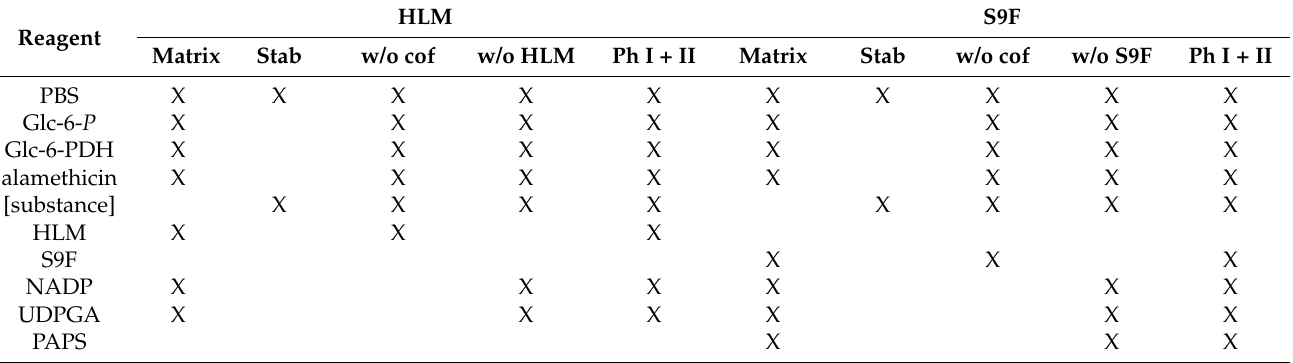
Table 3. Pipetting scheme of the human liver microsome and the human liver S9 fraction metabolism assay. HLM: human liver microsomes, S9F: human liver S9 fraction; matrix: matrix control, stab: stability control, w/o cof: control without cofactors, w/o HLM: control without HLM, w/o S9F: control without S9F, Ph I + II: phase I and II metabolism; PBS: phosphate-buffered saline; Glc-6- P : glucose-6-phosphate; Glc-6-PDH: glucose-6-phosphate dehydrogenase; NADP: β -nicotinamide adenine dinucleotide phosphate; UDPGA: uridine 5 (cid:48) -diphospho-glucuronic acid; PAPS: adenosine 3 (cid:48) - phosphate 5 (cid:48)